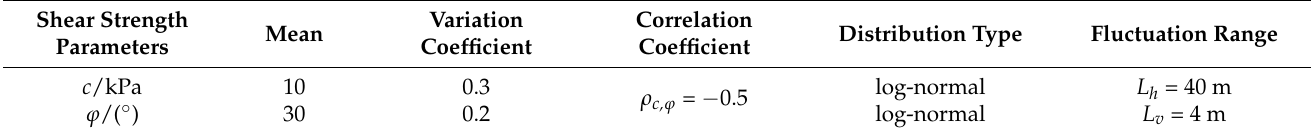
Table 2. Homogeneous slope reliability results of different methods.